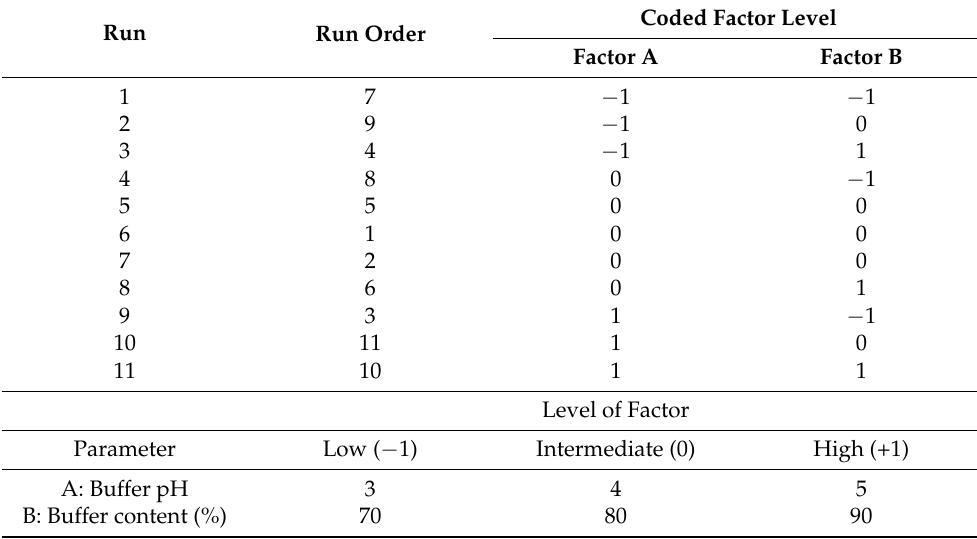
Table 1. Design matrix as per central composite design (CCD) for optimization of the HPLC method of metformin hydrochloride